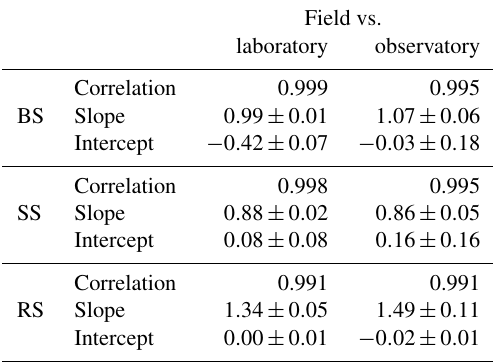
Table 3. Correlations and linear regression values (slope and in- tercept) for WLM metrics (baseline shift, BS; slope shift, SS; and residuals, RS) in field vs. reference